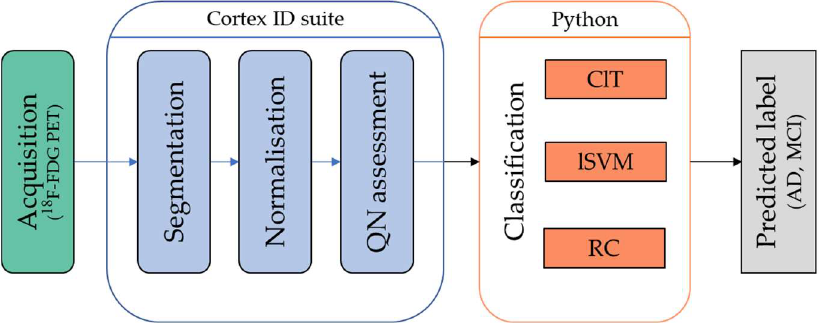
Figure 2. Overall procedure workflow .